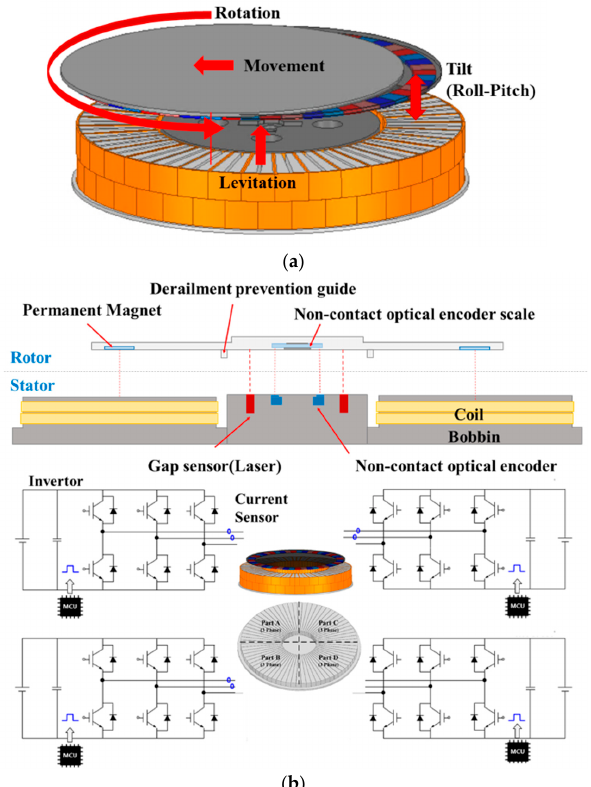
Figure 1. 6-DOF magnetic levitation system: ( a ) Axial flux permanent magnet Motor of ( b ) 4C1M system.